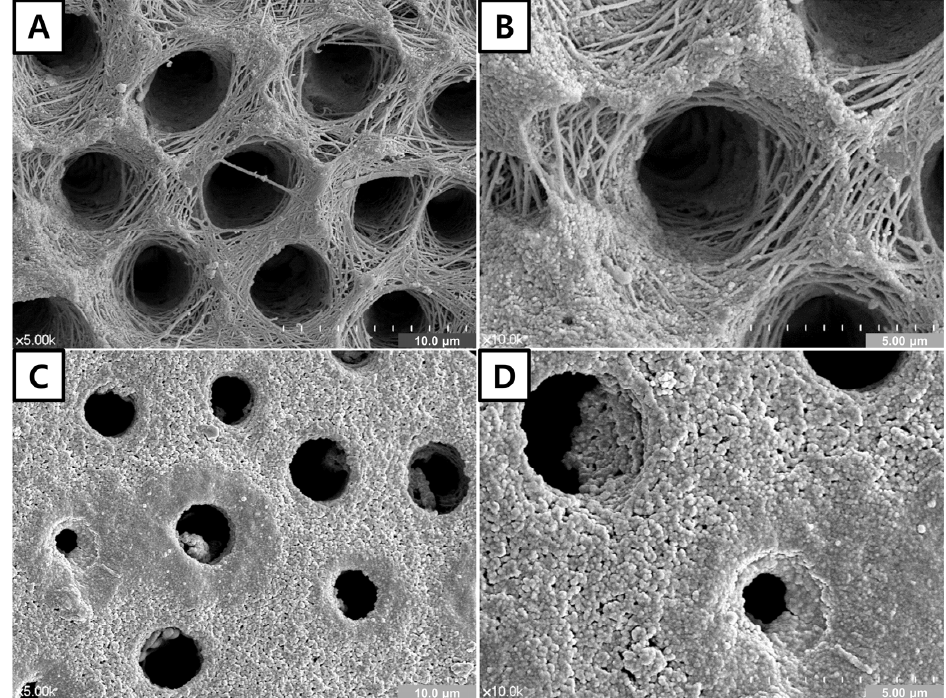
Figure 3. FE-SEM of the dentin surface. ( A ). Low magnification view ( × 5000). ( B ). High magnification view ( × 10,000) of SCA-approximated dentin surface. The exposed collagen network can be seen on the demineralized dentin surface. Some precipitates covering the dentin surface can be seen. ( C ). Low magnification view ( × 5000). ( D ). High magnification view ( × 10,000) of BCA-approximated dentin surface. The demineralized dentin surface was predominantly covered with small precipitates, and precipitates were observed inside the dentinal tubules, which obstructed dentinal tubule orifices.